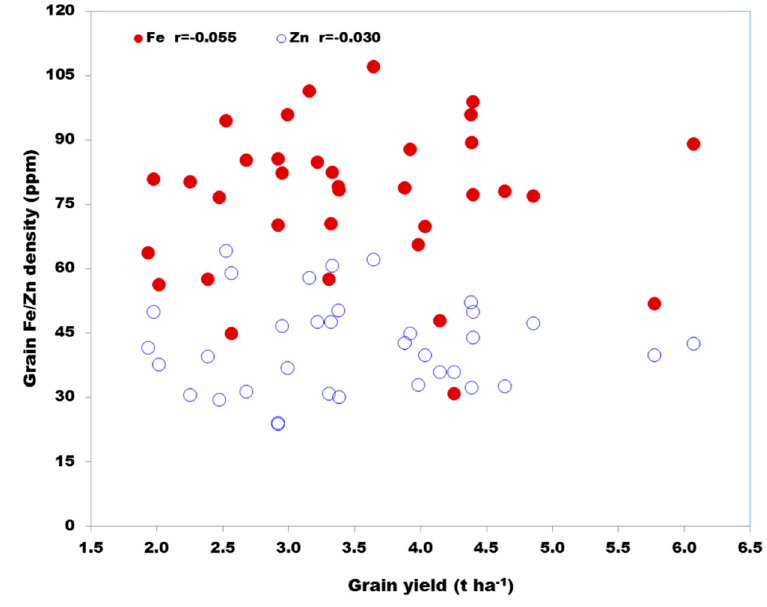
Figure 4. Relationship between the Fe / Zn density and grain yield in biofortified hybrid.